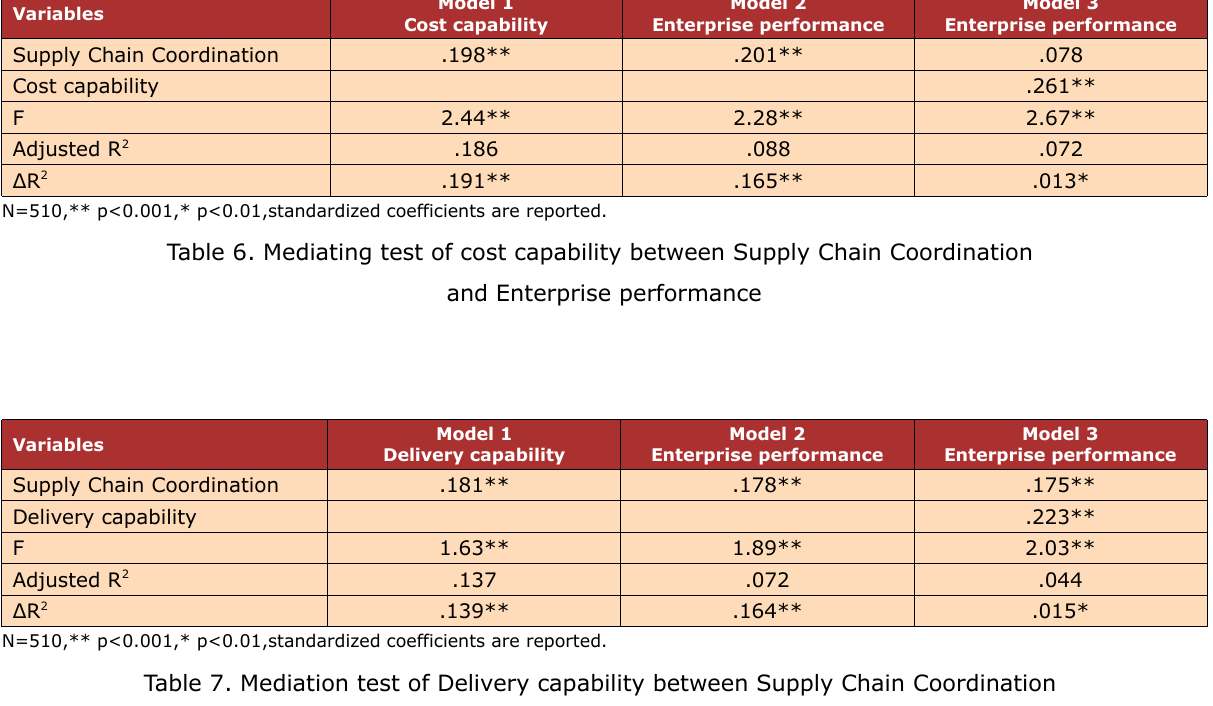
Table 7. Mediation test of Delivery capability between Supply Chain Coordination and Enterprise performance